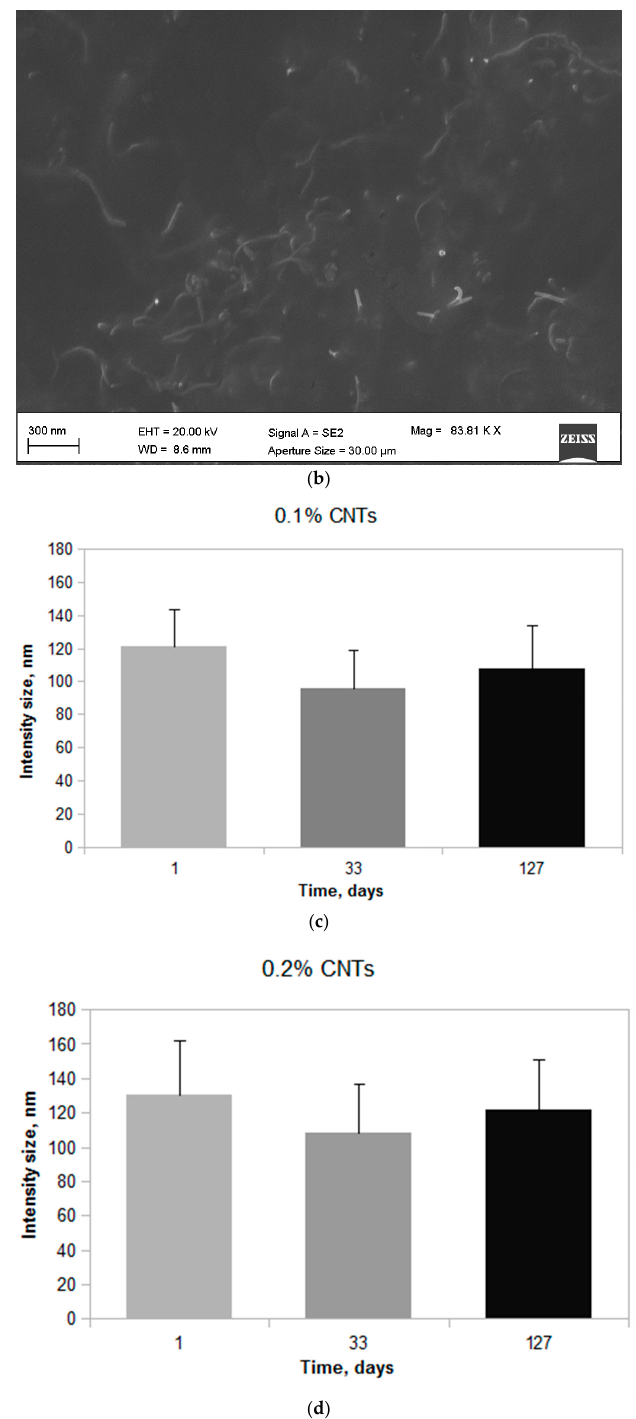
Figure 3. ( a , b ) SEM images of fracture (tensile) surfaces of CNTs epoxy samples (0.5 phr); ( c , d ) DLS measurements of the doped resin after different elapsed times for 0.1% and 0.2% phr, respectively.